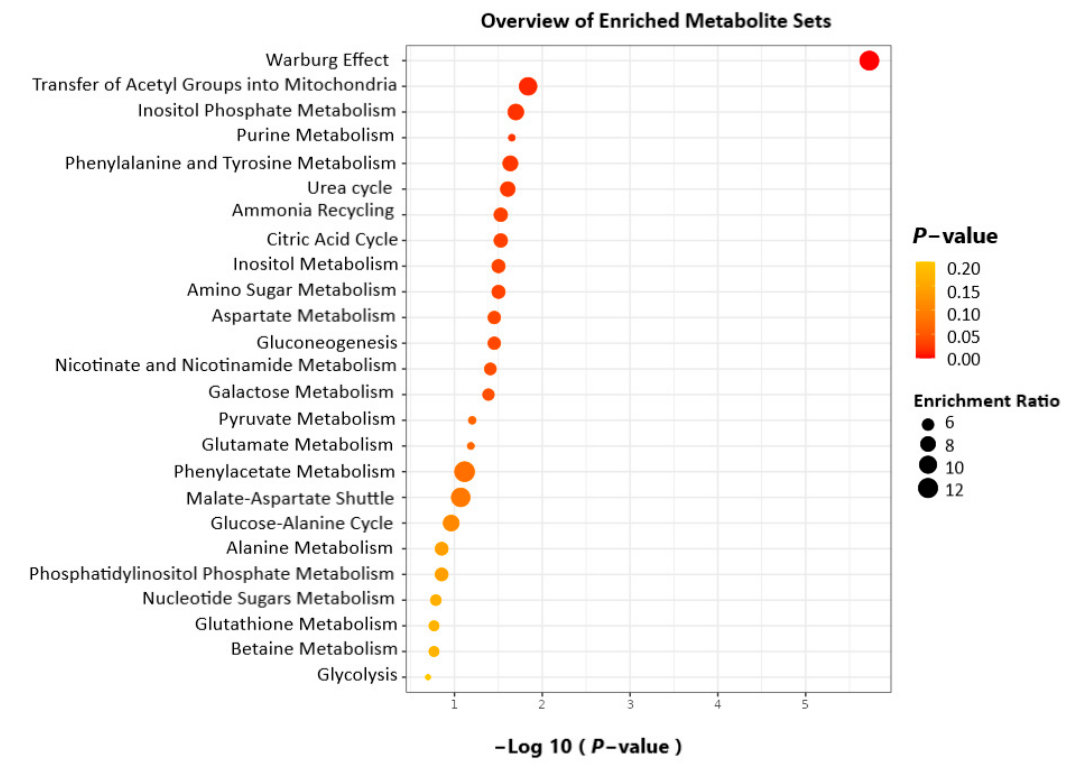
Pharmaceutics 2023 , 15 , 543 Figure 4. A metabolite set enrichment analysis (MSEA) of affected metabolites pointing out their physiological relevance.